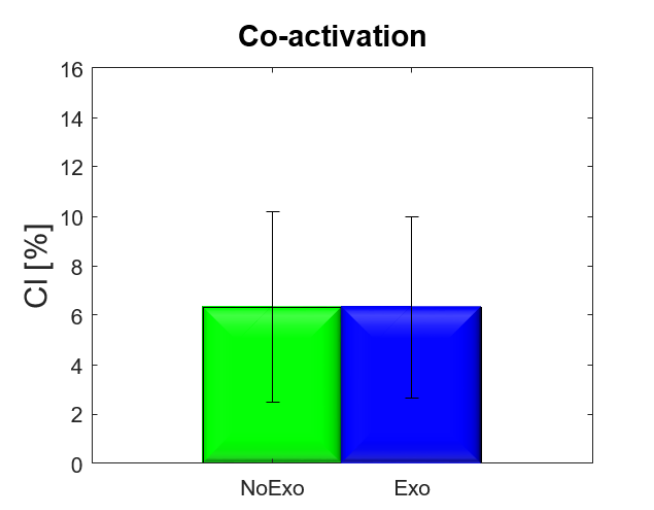
Figure 9. Mean (bars’ height) and standard deviation (vertical whiskers) of the co-activation index without and with the exoskeleton. The horizontal line with the asterisk denotes a statistically significant difference.